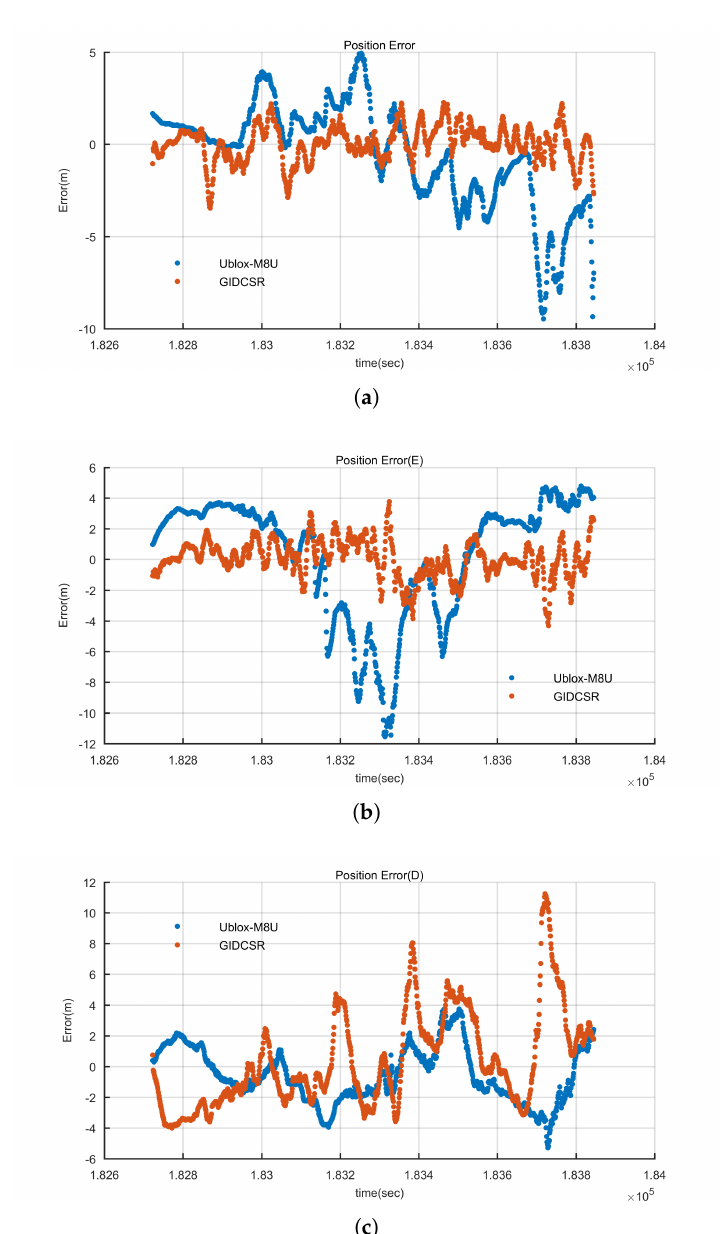
Figure 21. GNSS/INS integration errors comparison. ( a ) North direction ( b ) East direction ( c ) Height.